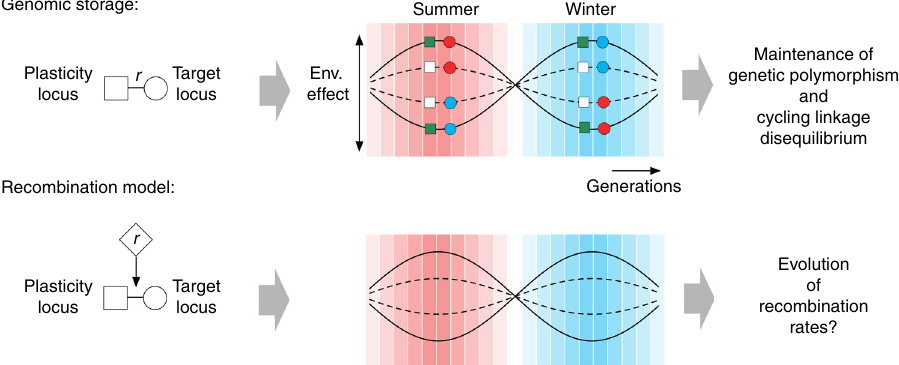
Fig. 1 Schematic representation of the genomic storage effect and the recombination model. As environmental effects oscillate, the summer (red circles) and the winter (blue circles) alleles at the target locus recombine to a less harmful genetic background at the plasticity modi fi er locus. The plasticity modi fi er locus modulates the effect of selection at the target locus by making alleles at the target locus more (non-plastic, dark squares) or less (plastic, light squares) sensitive to selection. The dynamics between the two loci allows unfavorable alleles to be stored until conditions change, generating the genomic storage effect 20 . The genomic storage effect generates both balanced polymorphism and cycling linkage disequilibrium. Here we study whether or not this type of cycling linkage disequilibrium can lead to the evolution of recombination in initially non-recombining monomorphic fi nite